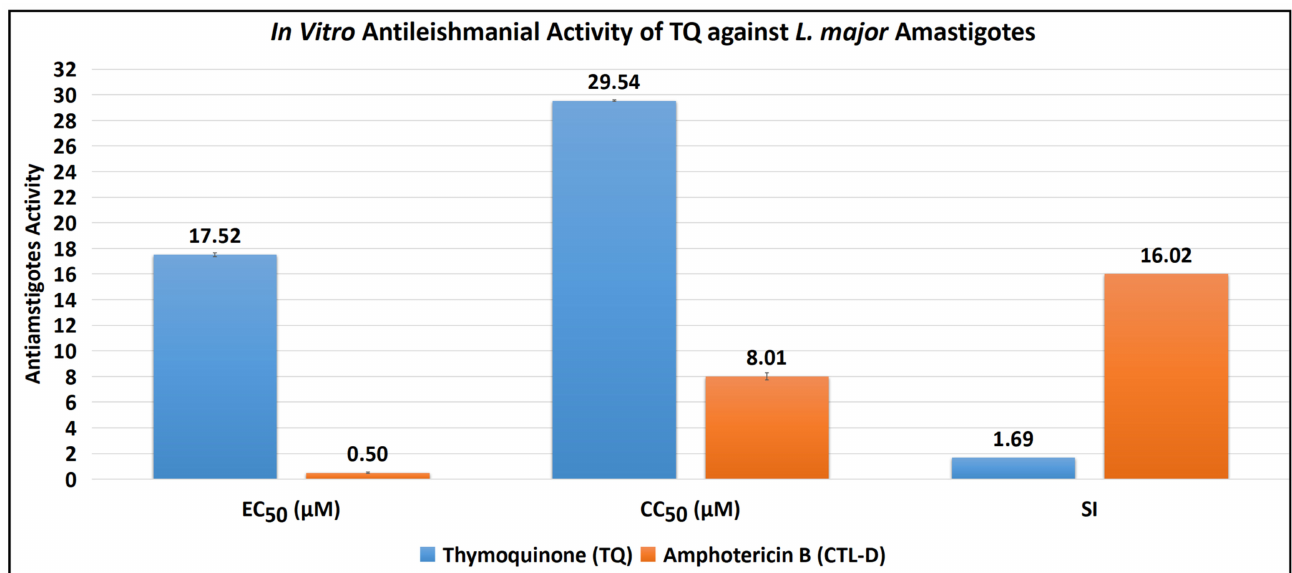
Figure 3. Antiamastigote activity of TQ and CTL-D.